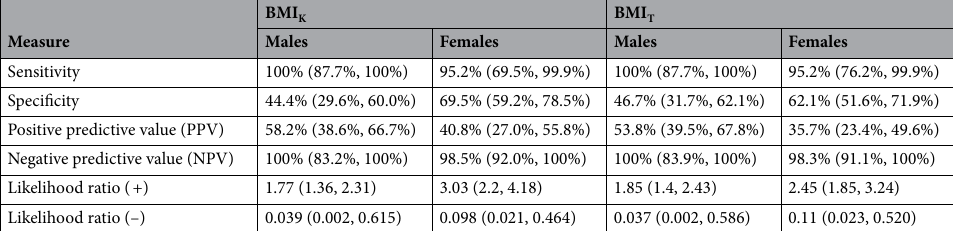
Table 7. Summary of measures of accuracy of BMI K and BMI T in diagnosing overweight–obese. The 95% CIs are indicated in parentheses. Overweight–obesity is defined as ≥ 25% BF in males and ≥ 35% body fat in females. The PPV and NPV were adjusted for sample prevalence of overweight-obese based on body fat percentage. BMI